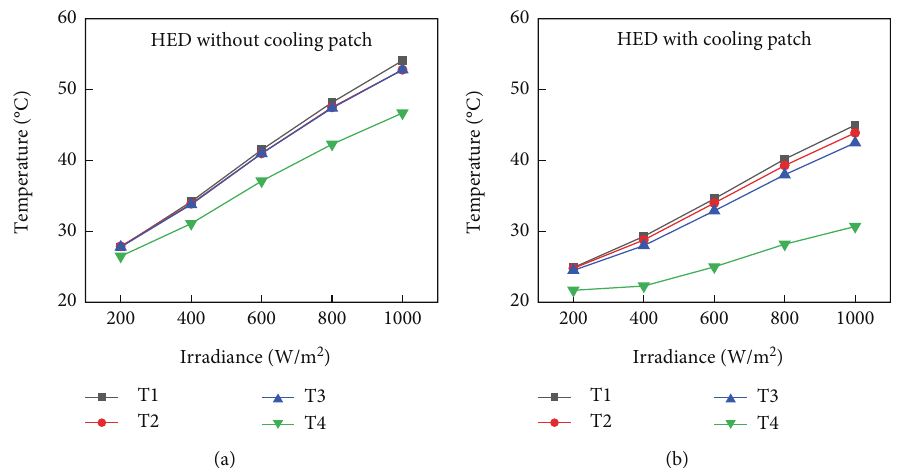
Figure 3: Temperatures of HEDs (a) without and (b) with the cooling patch at irradiances in the range of 200 to 1000 W/m 2 .